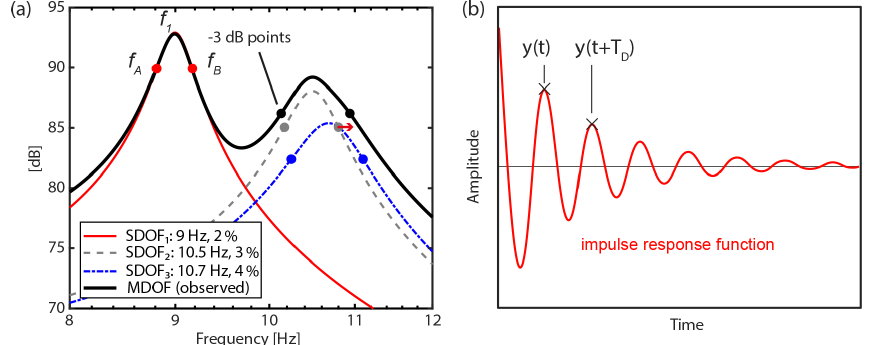
Figure 2. (a) Frequency response of three example single-degree-of-freedom (SDOF) systems with different damping ratios (%) and their superposition (a multi-degree-of-freedom-system, MDOF). Markers indicate the − 3dB or half-power points of each response curve, which are used to compute damping by the half-power bandwidth technique (see Eq. 1). Note that modes 2 and 3 merge to one single mode bell, which causes an overestimation of modal damping (4.1% instead of 3.0%; indicated by red arrow). The third mode at 10.7Hz cannot be observed (i.e., is hidden) in the MDOF power spectra. (b) Impulse response function of a structure resulting, for example, from active excitation. Damping is determined from the logarithmic decrement technique (Eq. 2) by measuring the amplitudes separated by one